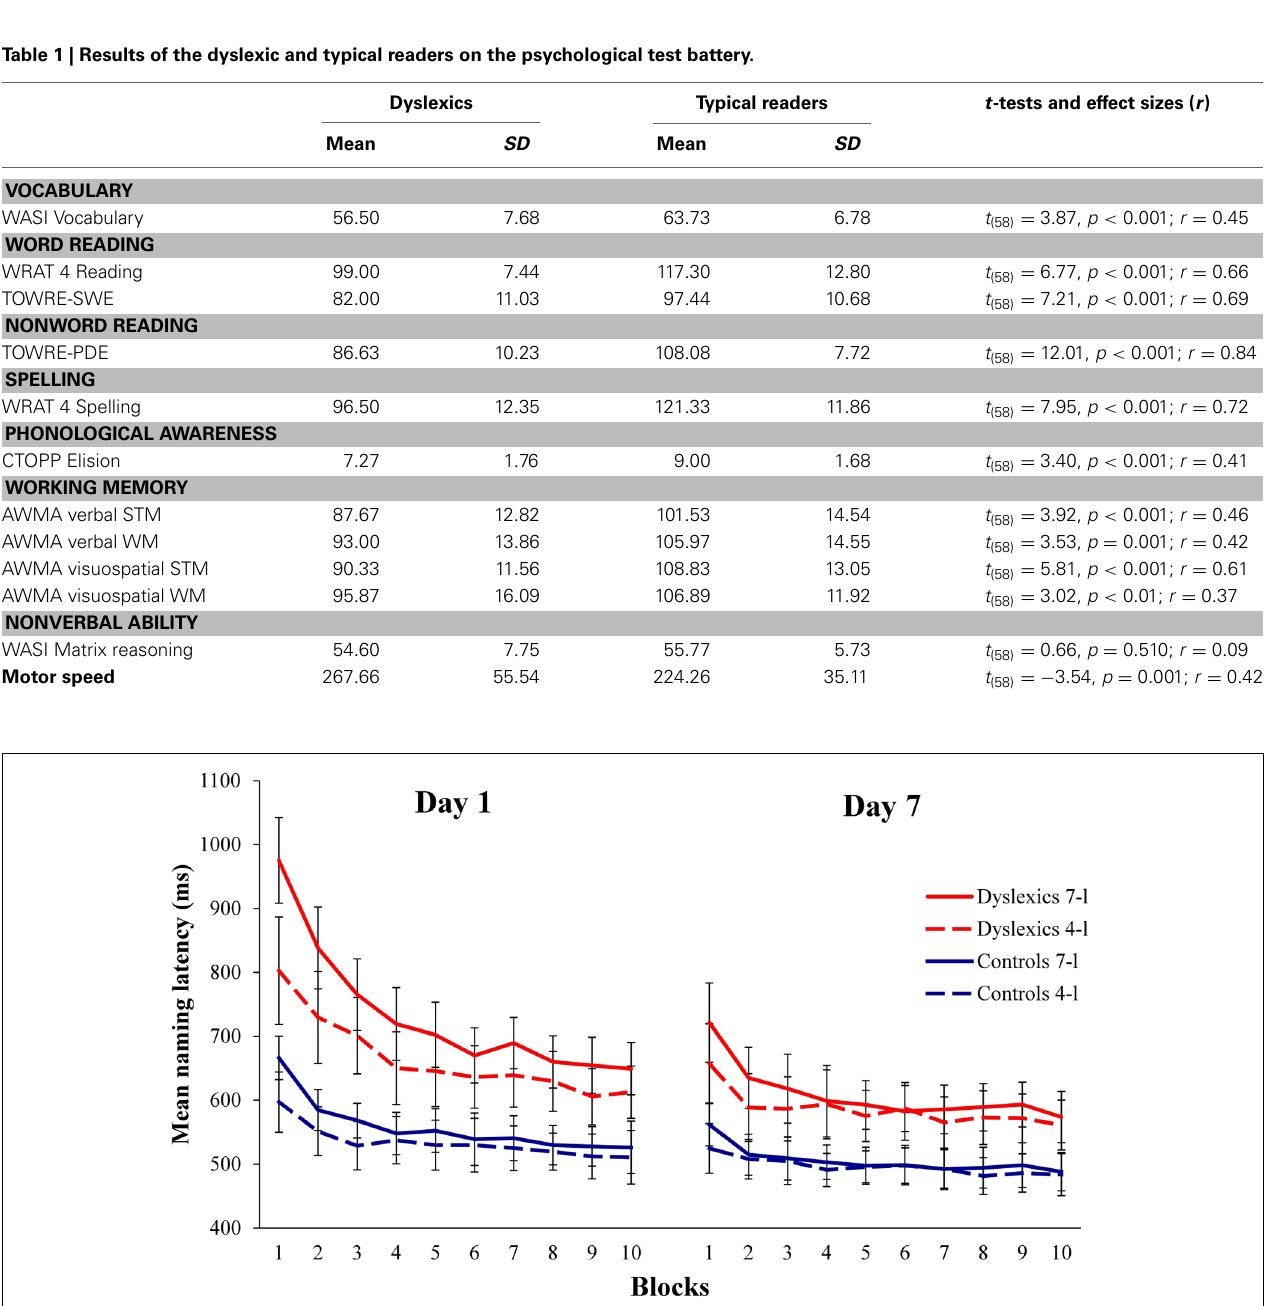
FIGURE 1 | Naming RTs to 4- and 7-letter nonwords in dyslexics and controls across two sessions (10 blocks per session). Error bars show 95%